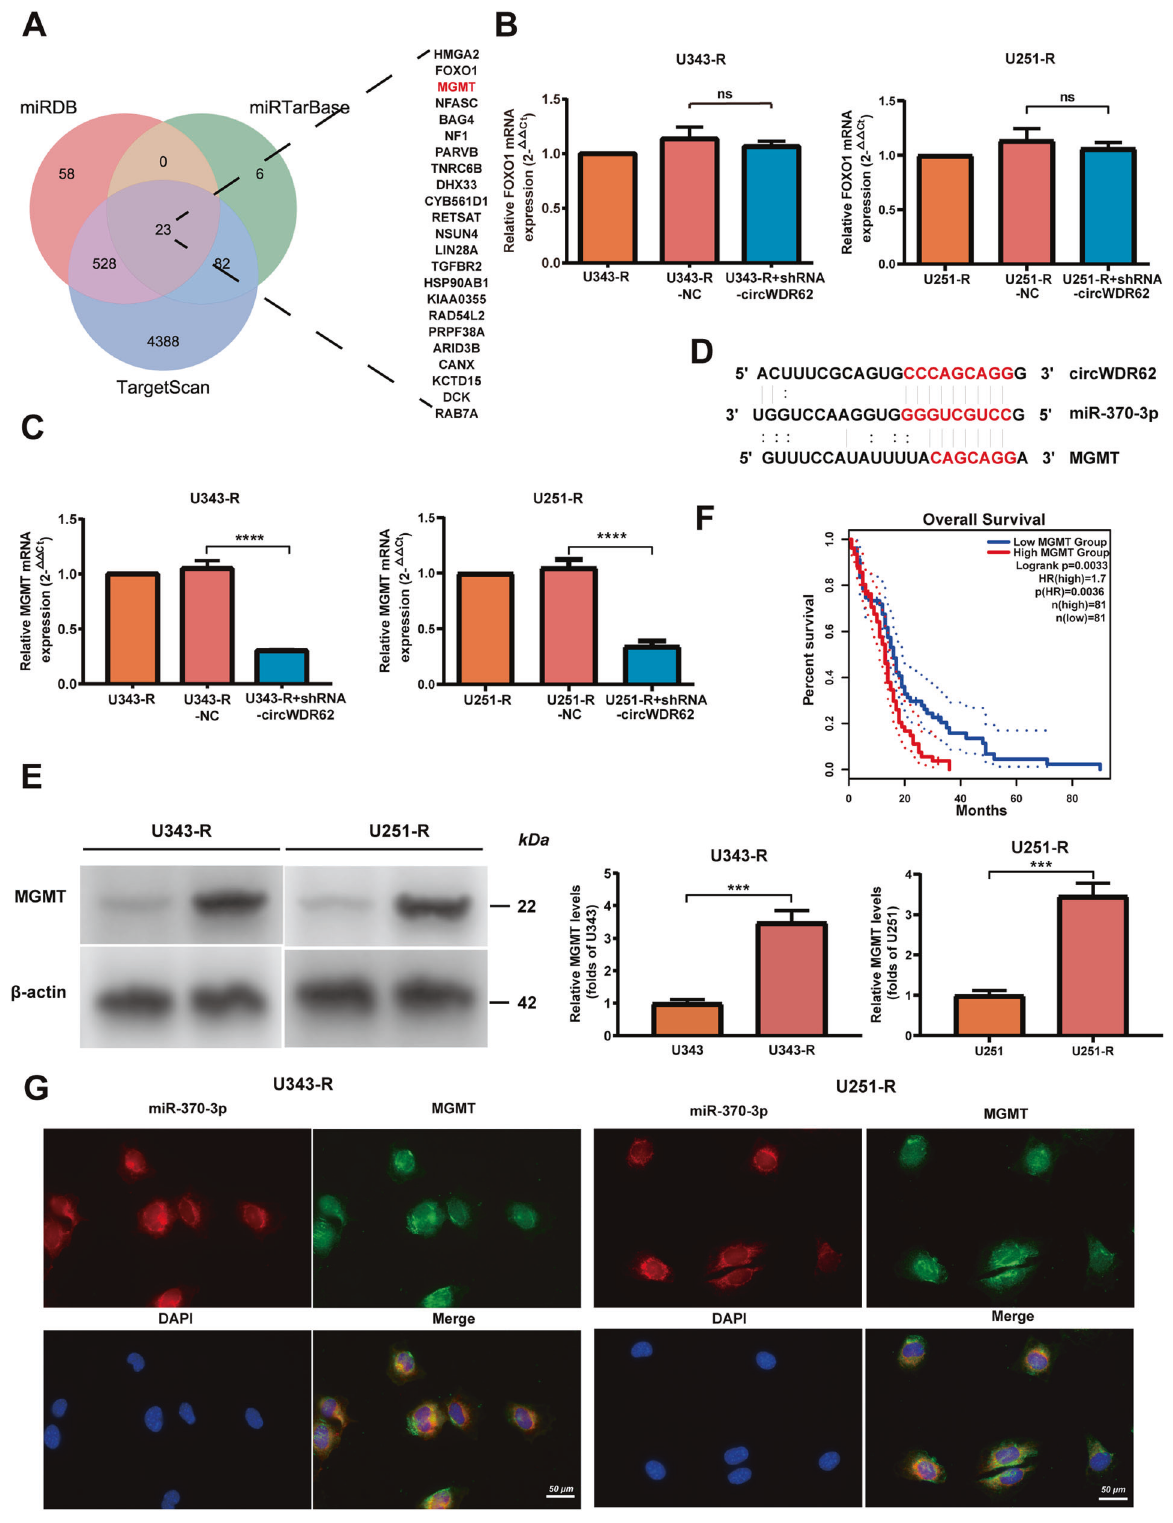
Fig. 4 MGMT is a direct target gene of the circWDR62/miR-370-3p axis in glioma. A Venn diagram of 23 potential target mRNAs of miR-370- 3p identi fi ed in three databases (miRDB, miRTarBase, and TargetScan). B , C Analysis of the expression of the potential targets FOXO1 ( B ) and MGMT ( C ) in the treated cells by qRT – PCR. D The binding sites of circWDR62, miR-370-3p and MGMT mRNA. E WB analysis was used to analyse the protein expression levels of MGMT in TMZ-resistant glioma cells and TMZ-sensitive glioma cells. F Prognostic analysis of MGMT expression by using the GEPIA2 database (http://gepia2.cancer-pku.cn/). G Colocalization of miR-370-3p and MGMT was analysed in U343-R and U251-R cells by FISH.